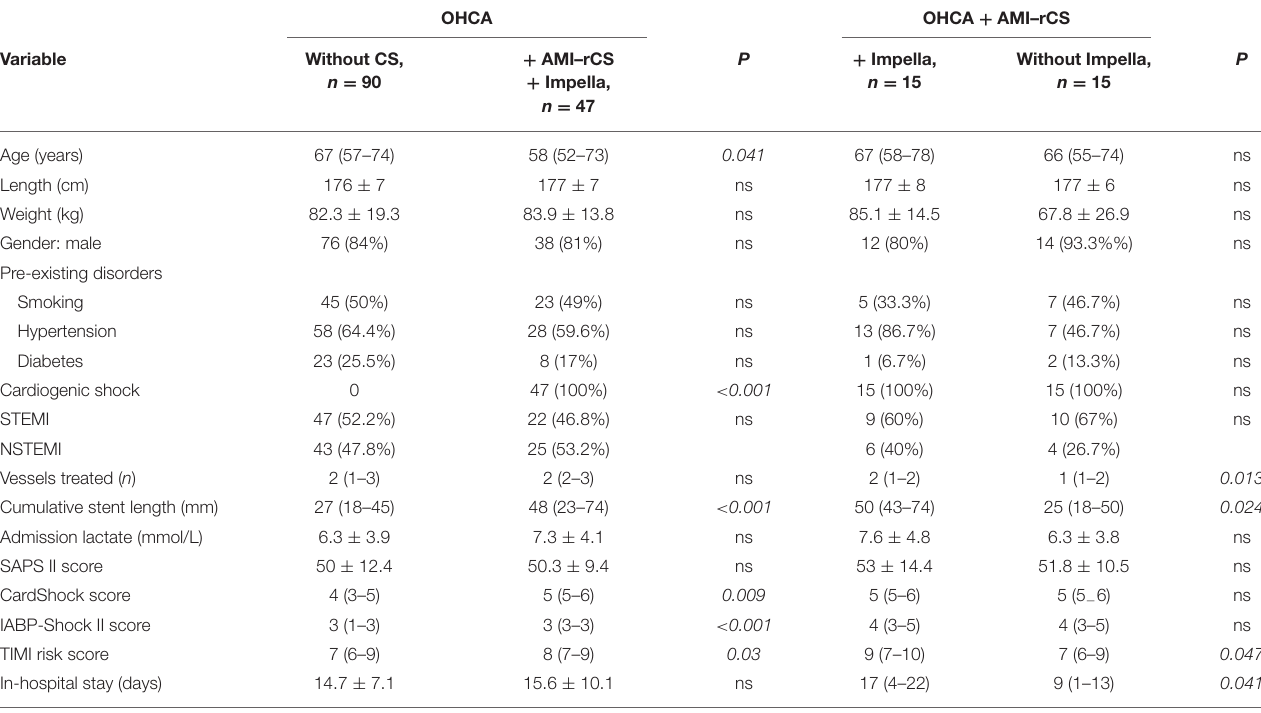
TABLE 1 | Baseline characteristics of propensity score-matched cohorts.